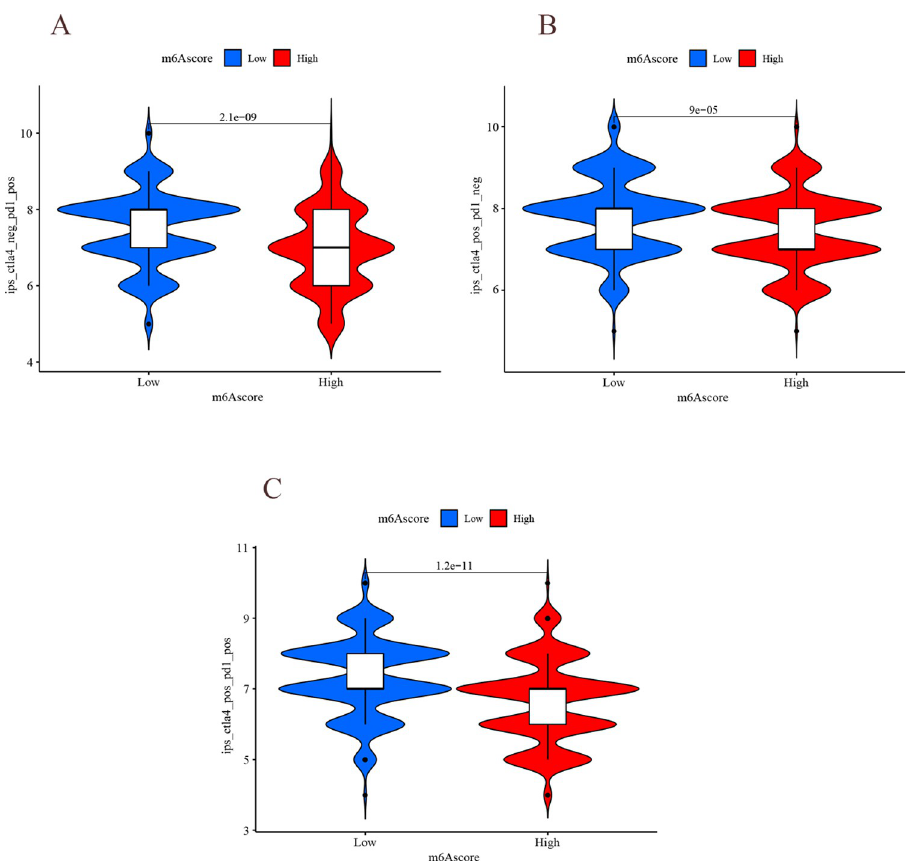
Fig 16. Analysis of immune˚checkpoint molecules. (A) Horizontal coordinate indicates m 6 A score, and vertical coordinate indicates the effect of PD-L1 treatment. (B) Horizontal coordinates indicate m 6 A score, and vertical coordinates indicate the effect of CTLA4 treatment. (C) Horizontal coordinates indicate m 6 A score, and vertical coordinates indicate CTLA4 combined with the effect of PD-L1 treatment.